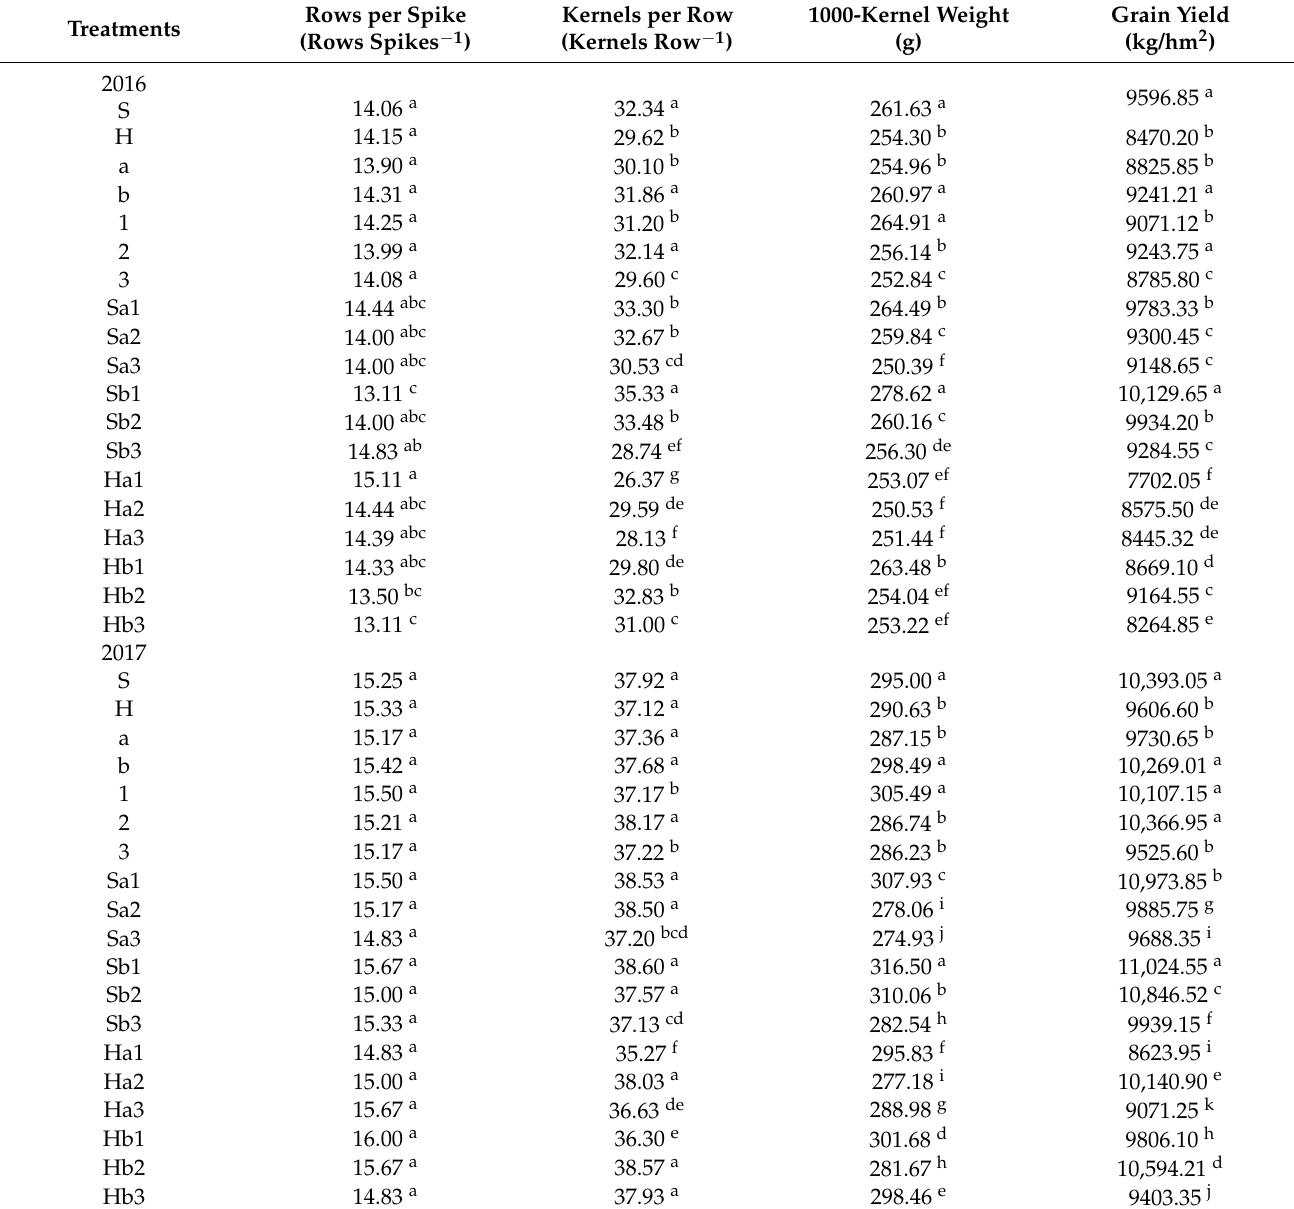
Table 4. Grain yield and yield compositions of summer maize during the 2016 and 2017 growing